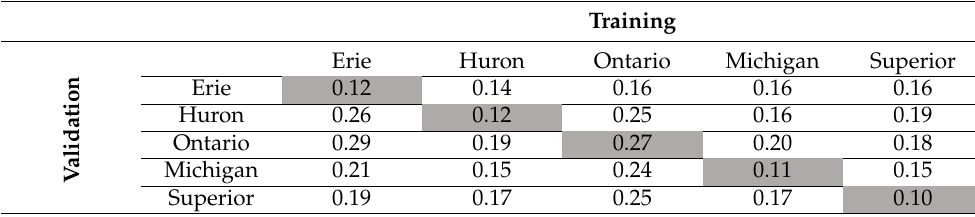
Table 6. Summary statistics of the ubRMSE on the estimation of water surface elevations using a random forest model trained using I , C , and W variables over a lake and applied to the remaining four. The diagonal line represents the results of the 5-fold